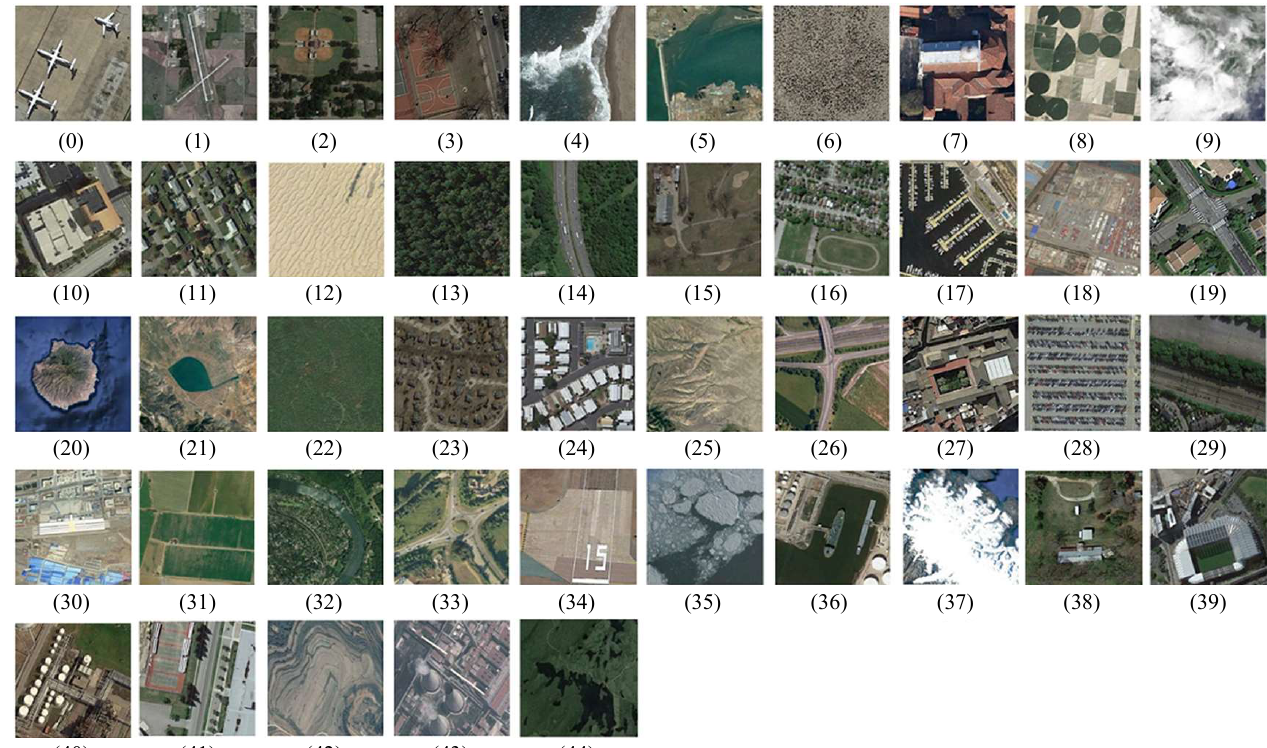
Figure 5. Some examples from the NWPU-RESISC45 dataset. (0) Airplane, (1) airport, (2) baseball diamond, (3) basketball court, (4) beach, (5) bridge, (6) chaparral, (7) church, (8) circular farmland, (9) cloud, (10) commercial area, (11) dense residential, (12) desert, (13) forest, (14) freeway, (15) golf course, (16) ground track field, (17) harbor, (18) industrial area, (19) intersection, (20) island, (21) lake, (22) meadow, (23) medium residential, (24) mobile home park, (25) mountain, (26) overpass, (27) palace, (28) parking lot, (29) railway, (30) railway station, (31) rectangular farmland, (32) river, (33) round- about, (34) runway, (35) sea ice, (36) ship, (37) snow berg, (38) sparse residential, (39) stadium, (40) storage tank, (41) tennis court, (42) terrace, (43) thermal power station, (44)